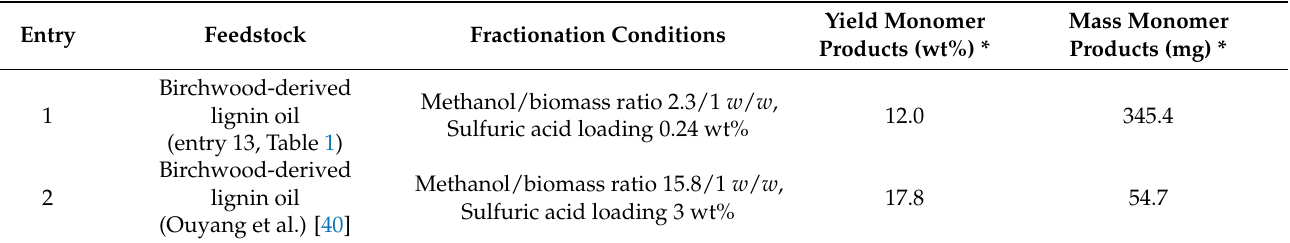
Table 3. Results of reductive depolymerization of birchwood-derived lignin oils obtained under different fractionation conditions.